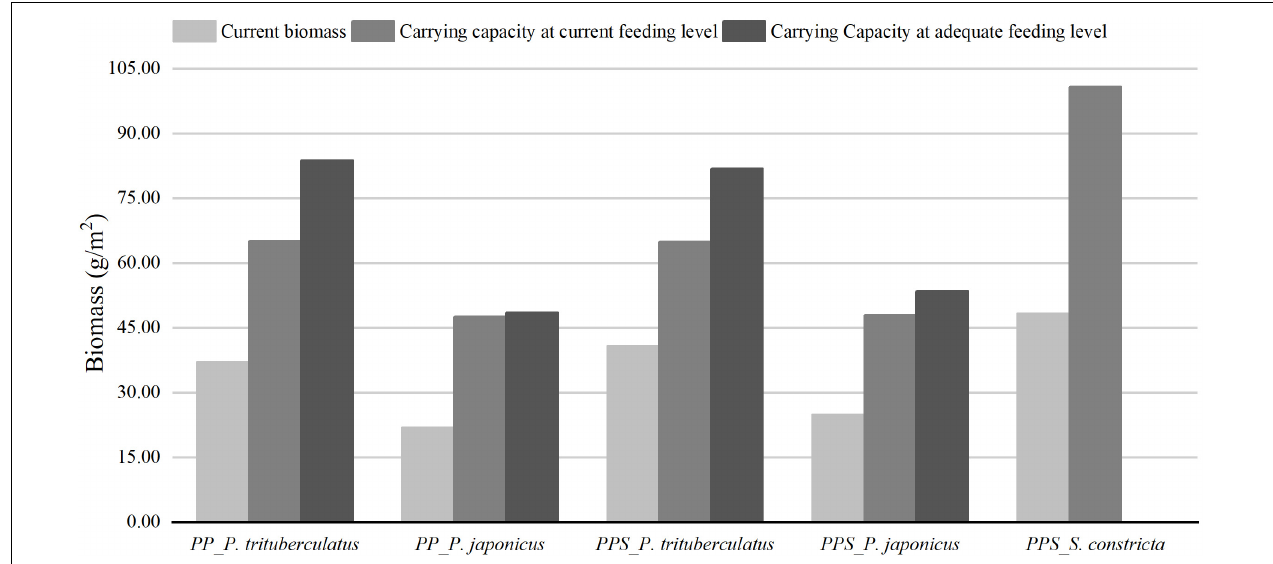
FIGURE 2 | Current biomass and carrying capacity of Portunus trituberculatus and Penaeus japonicus in the integrated pond aquaculture ecosystem of Portunus trituberculatus – Penaeus japonicus (PP), and current biomass and carrying capacity of Portunus trituberculatus , Penaeus japonicus , and Sinonovacula constricta in the integrated pond aquaculture ecosystem of Portunus trituberculatus – Penaeus japonicus – Sinonovacula constricta (PPS).